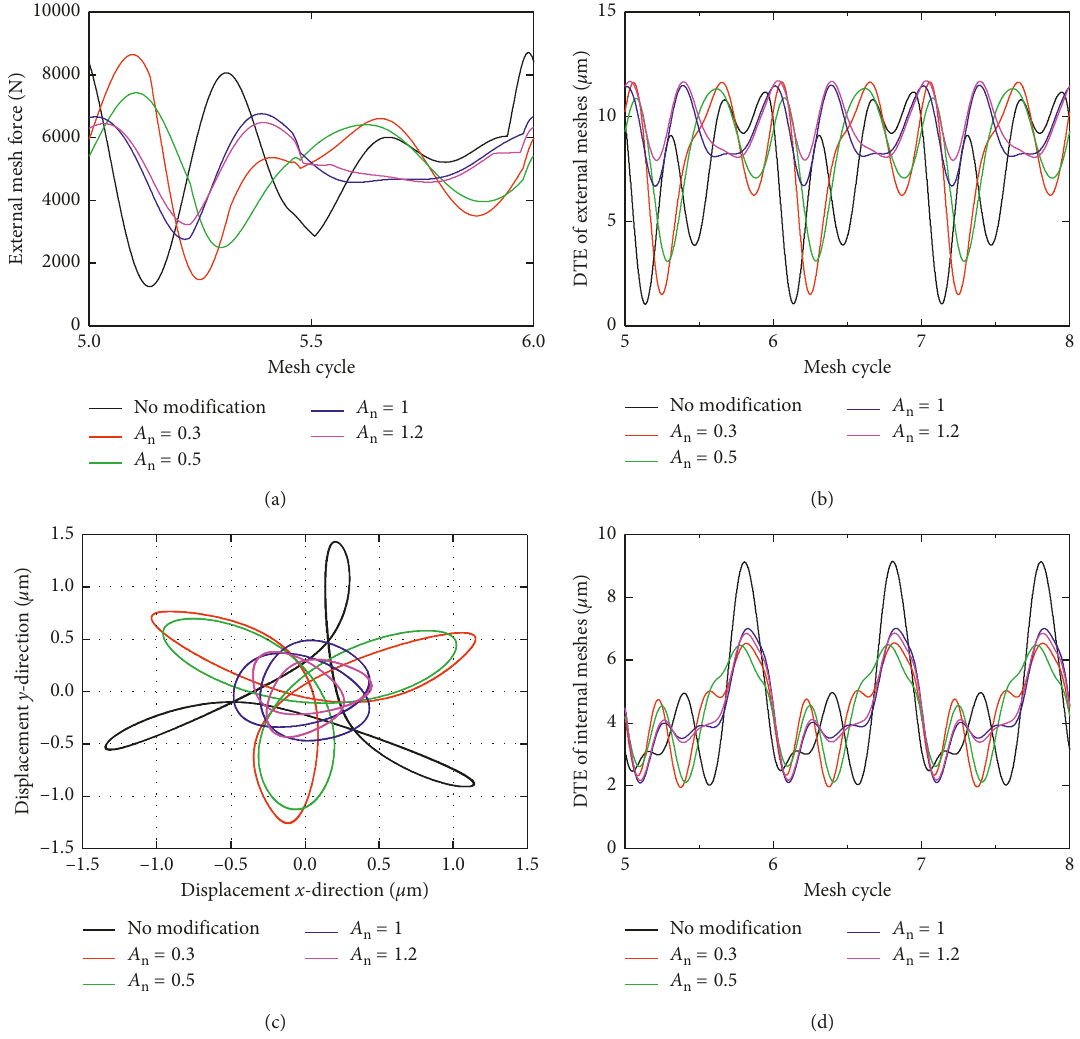
Figure 13: Dynamic responses for different normalized modification angles on external and internal meshes at sun-gear speed 6800rpm: (a) dynamic mesh force; (b) DTE of sun-planet meshes; (c) sun-gear trajectory; (d) DTE of ring-planet meshes.